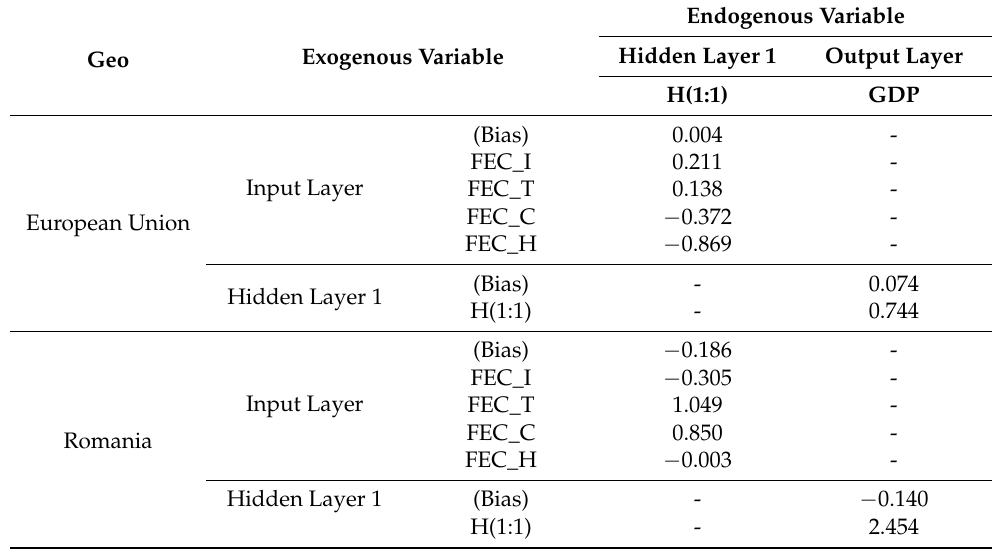
Table 5. Estimation of MLP network parameters on final energy consumption by sector and economic